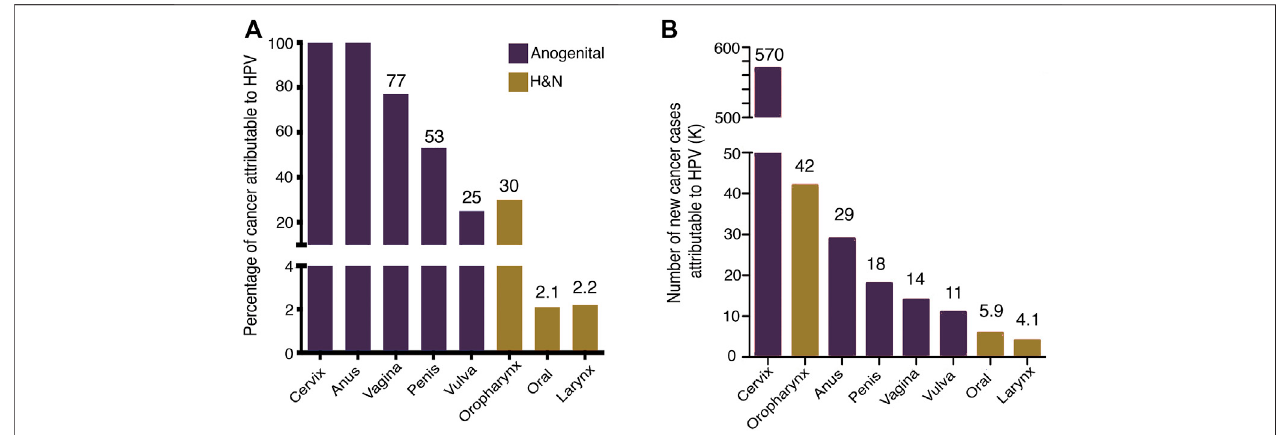
FIGURE1| HPV-attributable cancer. (A) The graphshowstheproportion ofcancerattributabletoHPVworldwide (B) Number ofnewcancercasesattributableto HPV. Data from de Martel et al. (2020).